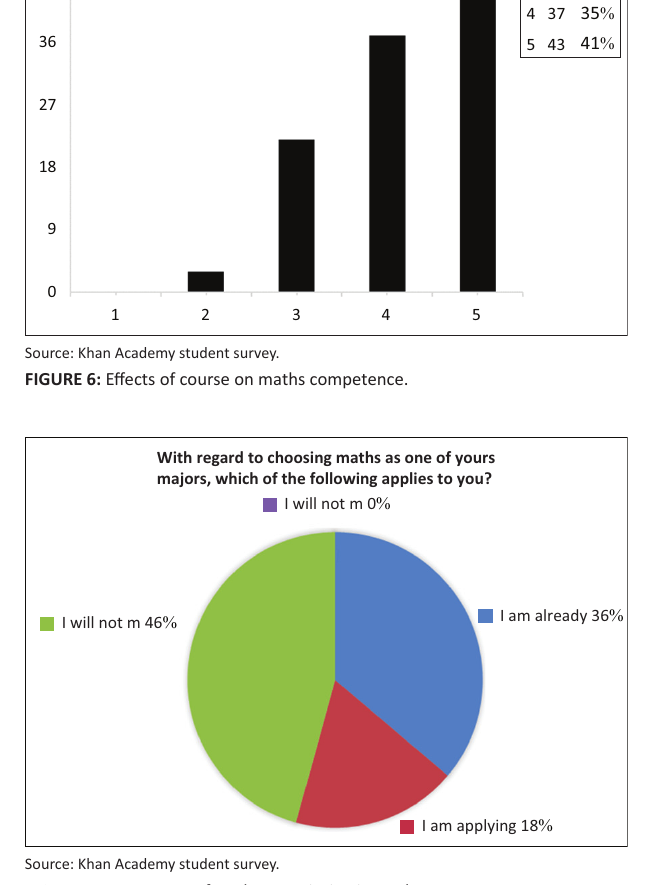
FIGURE 7: Percentage of students majoring in